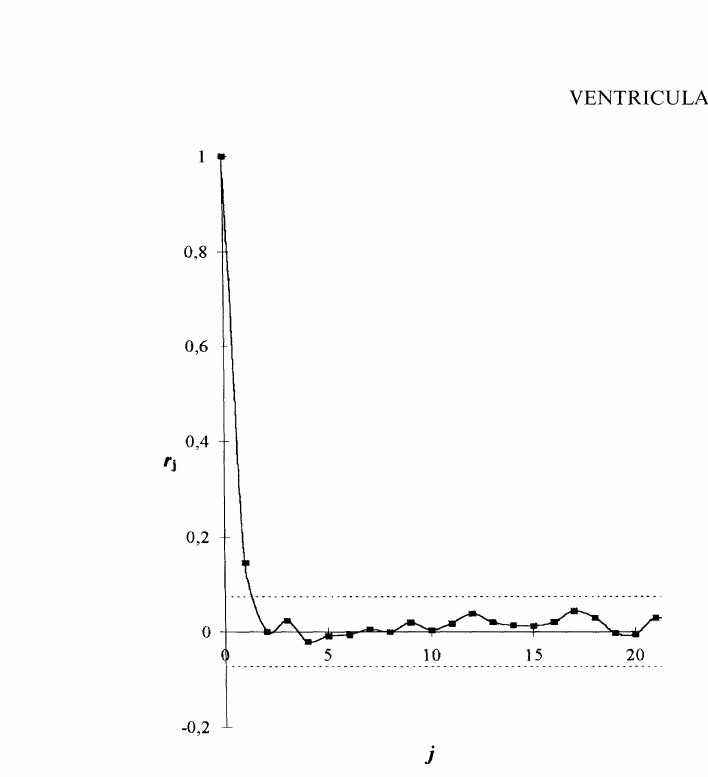
FIGURE 4 Typical autocorrelation curve: The dotted lines represent the treshold beyond which r./ is significant (p < 0.001). r# is highly significant only for j=